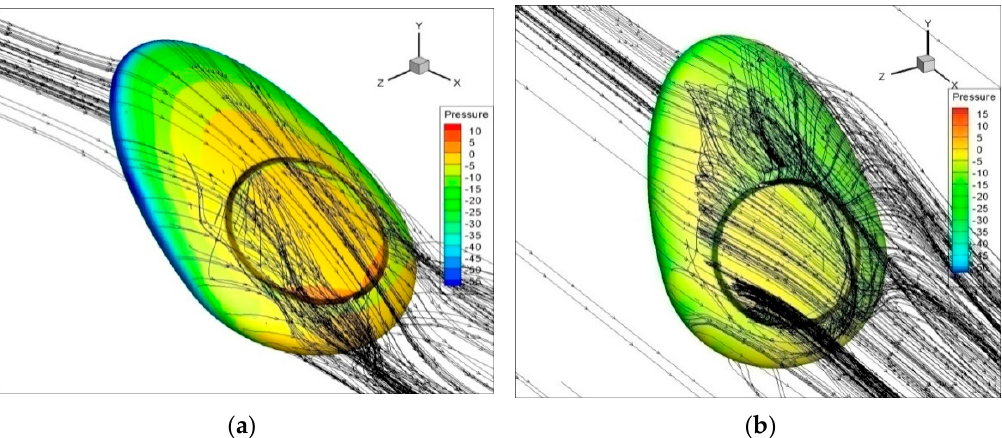
Figure 14. The flow behavior of the hybrid airship for δ = 0.025 at ( a ) α = 40° (pre-stall region) and ( b ) α = 60° (post-stall region).